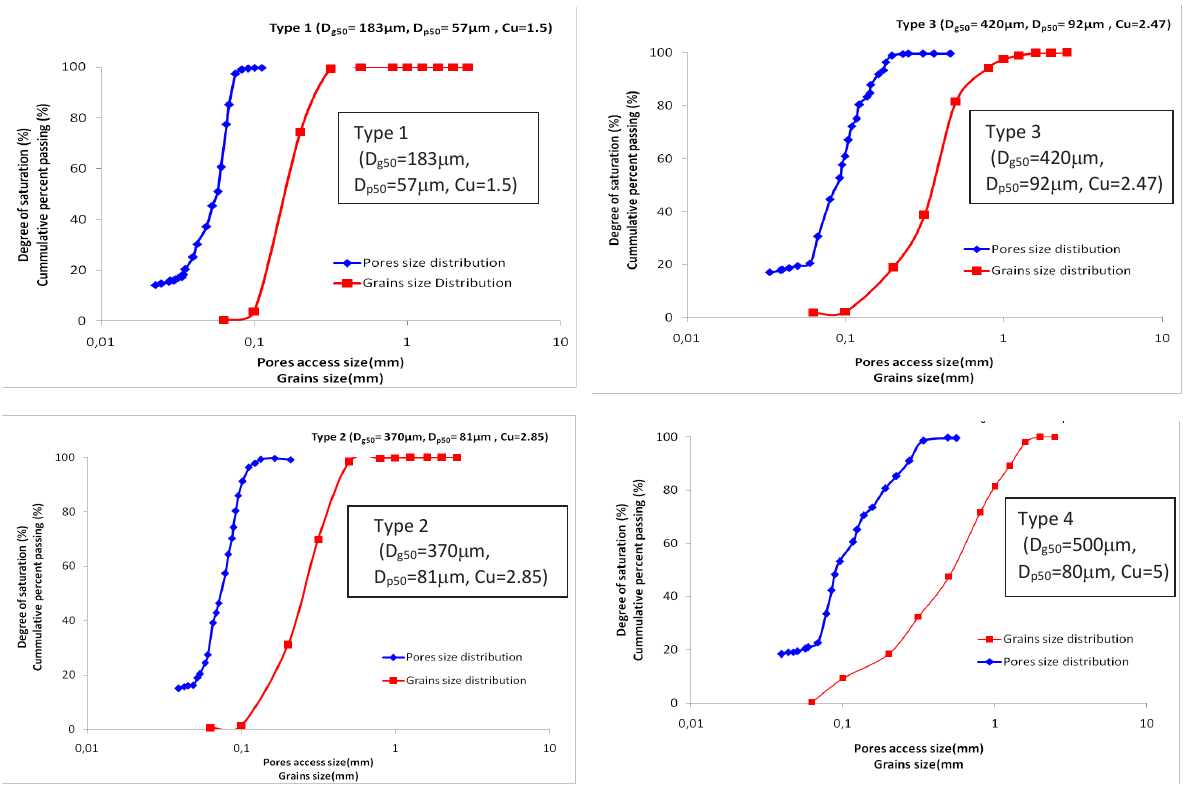
Figure 15: Pore-access size distributions for all four types of sand.